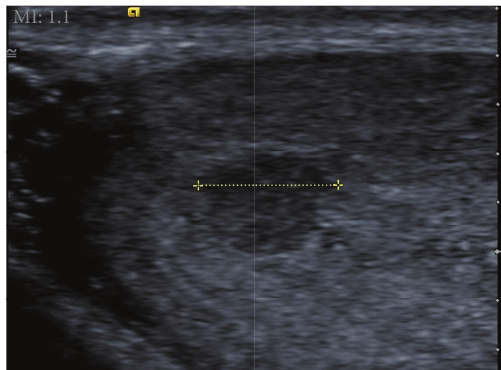
Figure 1: Gray-scale ultrasound image reveals a hypoechoic solid mass within the left testis.